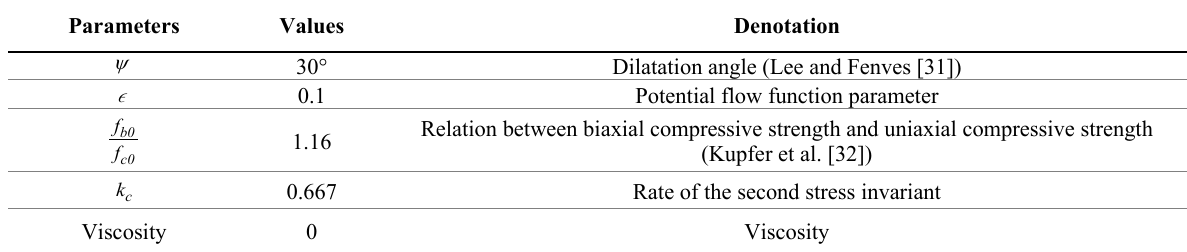
Table 2. Plasticity parameters of the CDP